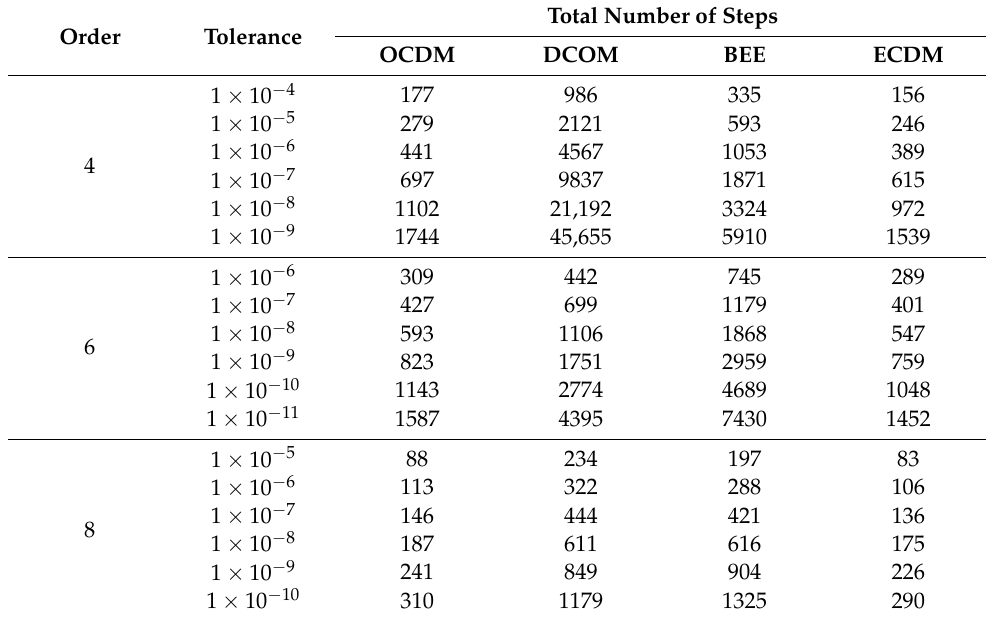
Figure 8. Performance plots for two-body problem simulation by solvers of orders 4 ( a ), 6 ( b ), and 8 ( c ).